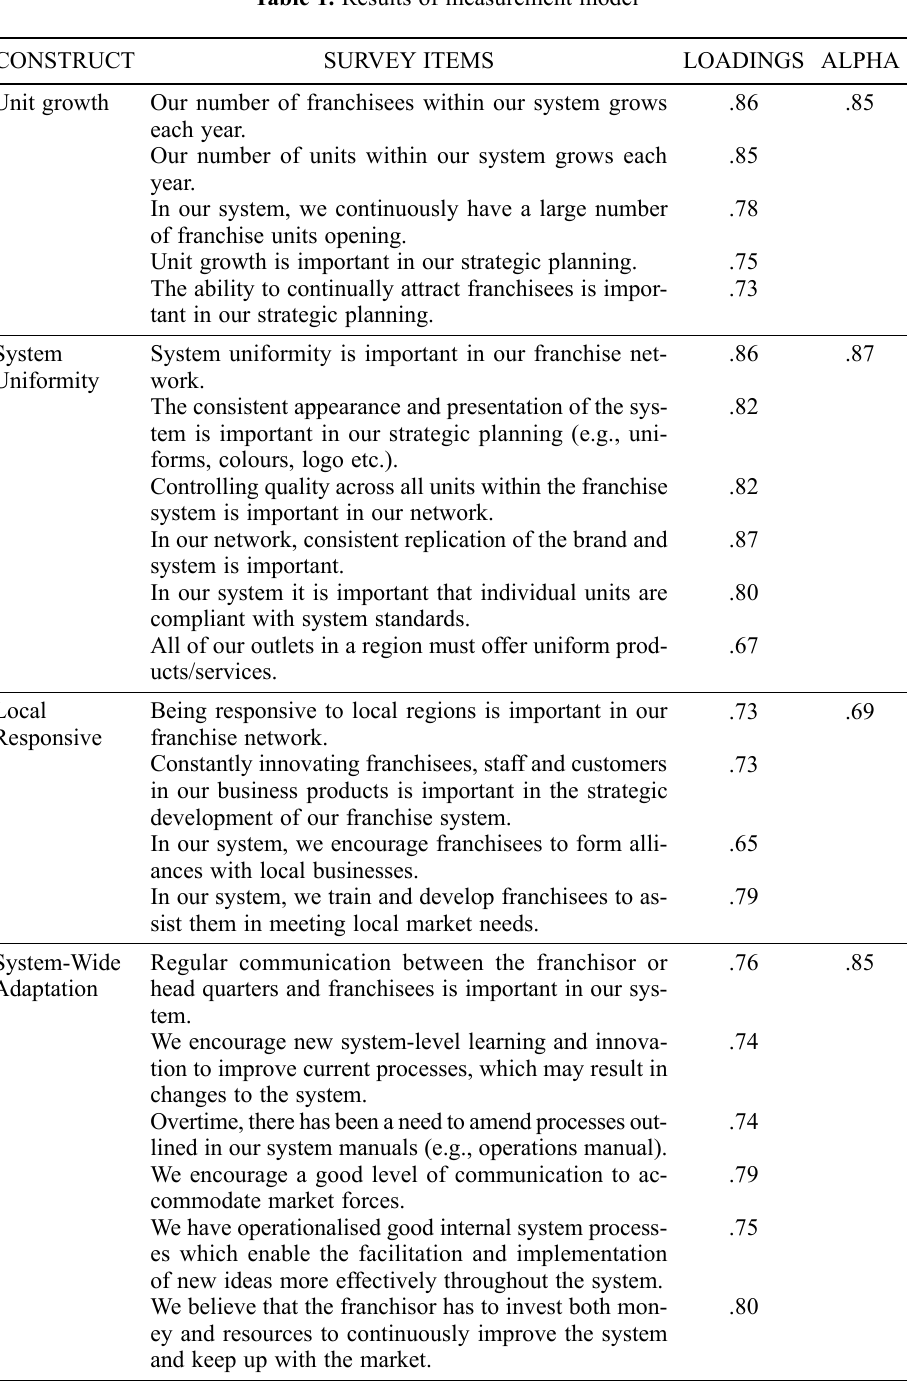
Table 1. Results of measurement